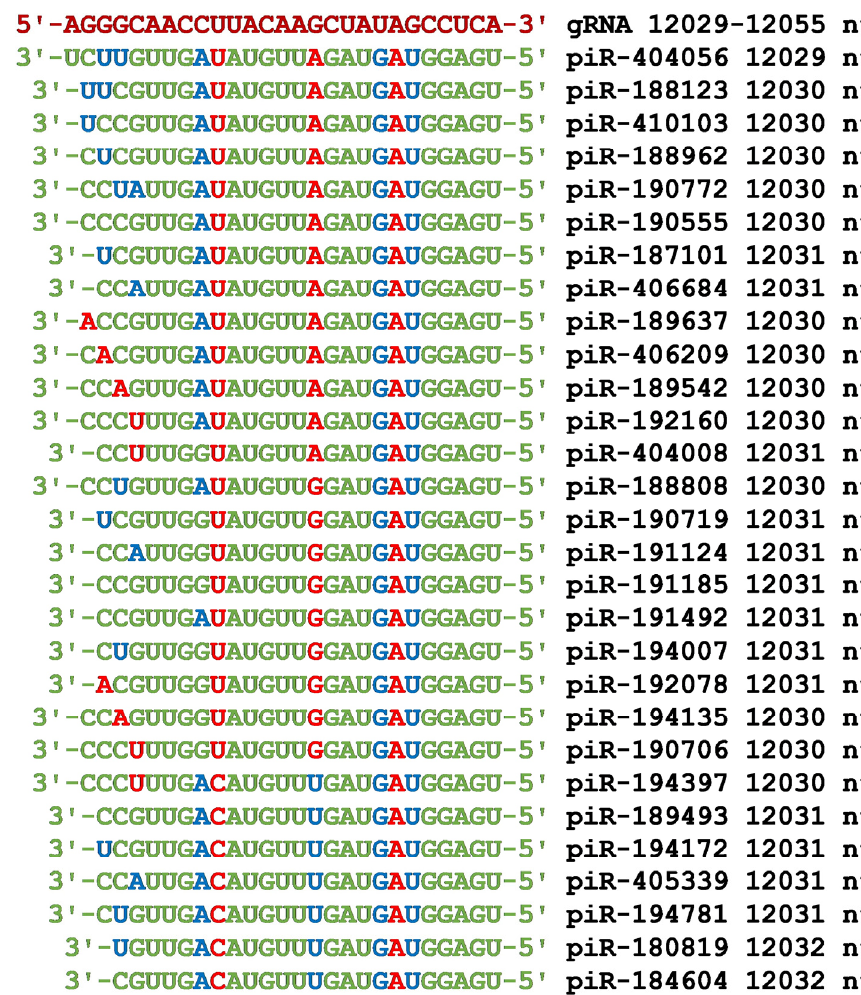
Figure 7. Nucleotide sequences of the 29 piRNA BSs cluster in the CDS of gRNA from 12,029 nt to 12,055 nt and the nucleotide sequences of piRNAs. Note: The piRNA nucleotides that form canonical pairs with gRNA are highlighted in green and non ‐ canonical pairs are highlighted in blue. The piRNA nucleotides that do not interact with gRNA are highlighted in red. The names of the piRNAs are followed by the beginning of their BSs.